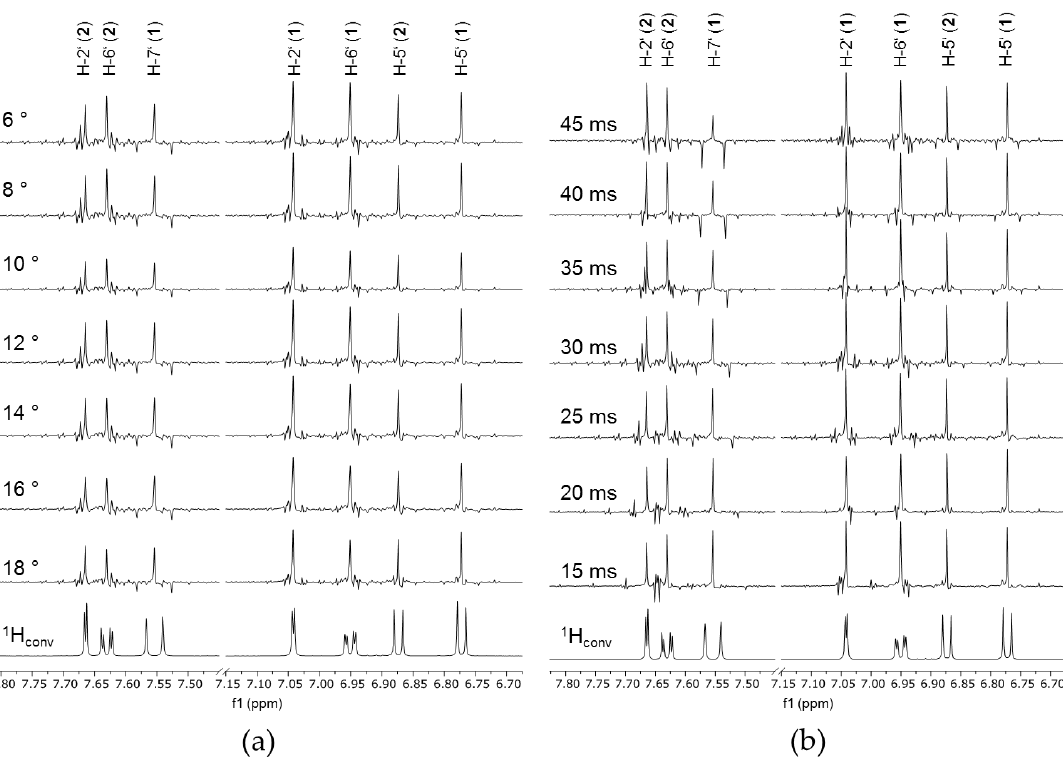
Figure 2. PSYCHE spectra section of compound mixture of chlorogenic acid ( 1 ) and rutin ( 2 ) with ( a ) constant τ PS (30 ms) and varied pulse angle, and ( b ) constant pulse angle (10 ◦ ) and varied τ PS.